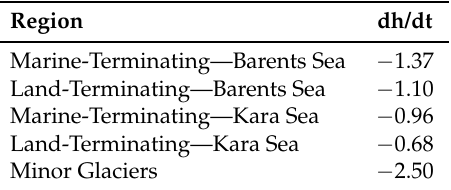
Table 3. Ice Thinning Rate measured by CryoSat-2 below 500 m near the glacier frontal areas. NZEM glaciers are classified according coast and terminus type. Thinning rates are expressed in meters per year [m/year]. Region